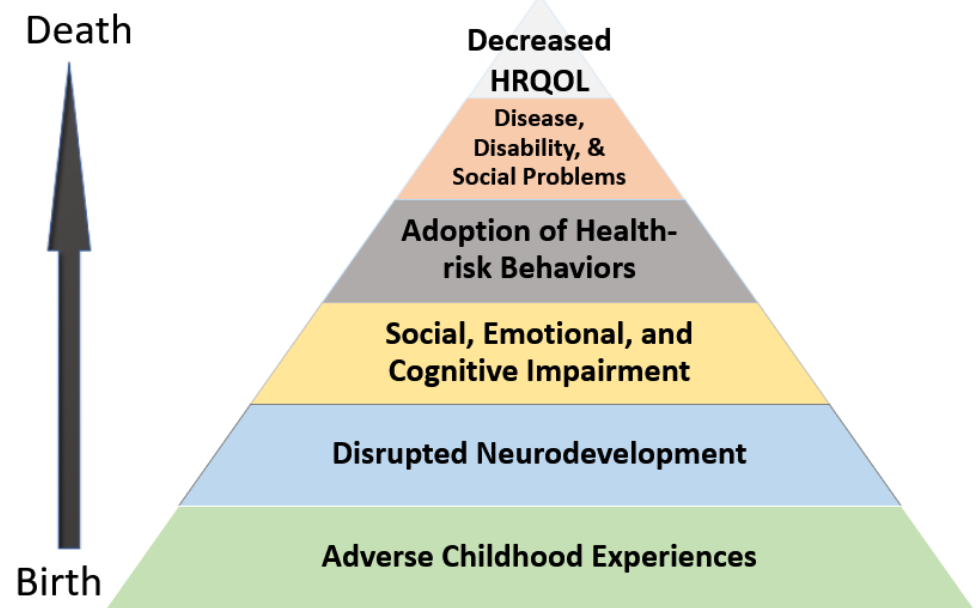
Figure 1. ACE Pyramid for HRQROL—modified according to potential influences throughout the lifespan of ACE [28].